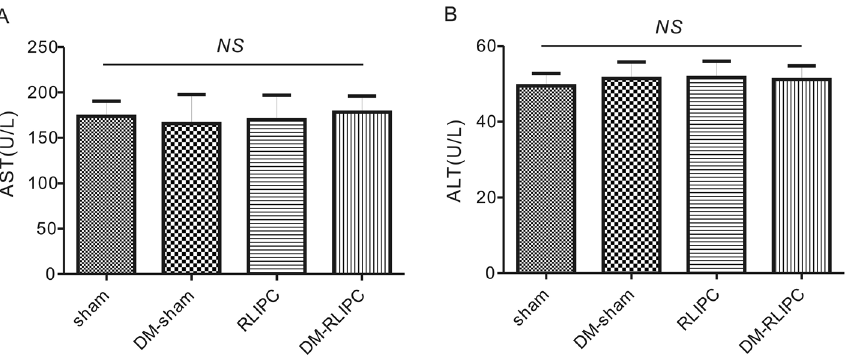
Figure 3. Remote ischemic preconditioning did not cause liver injury. ( A ) Plasma AST (n = 5–6); ( B ) plasma ALT (n = 5–6). Sham, sham surgery; RLIPC, remote liver ischemic preconditioning; DM: diabetic rats. Data presented as mean ± SEM. NS: non-significant between groups ( p > 0.05, by one-way